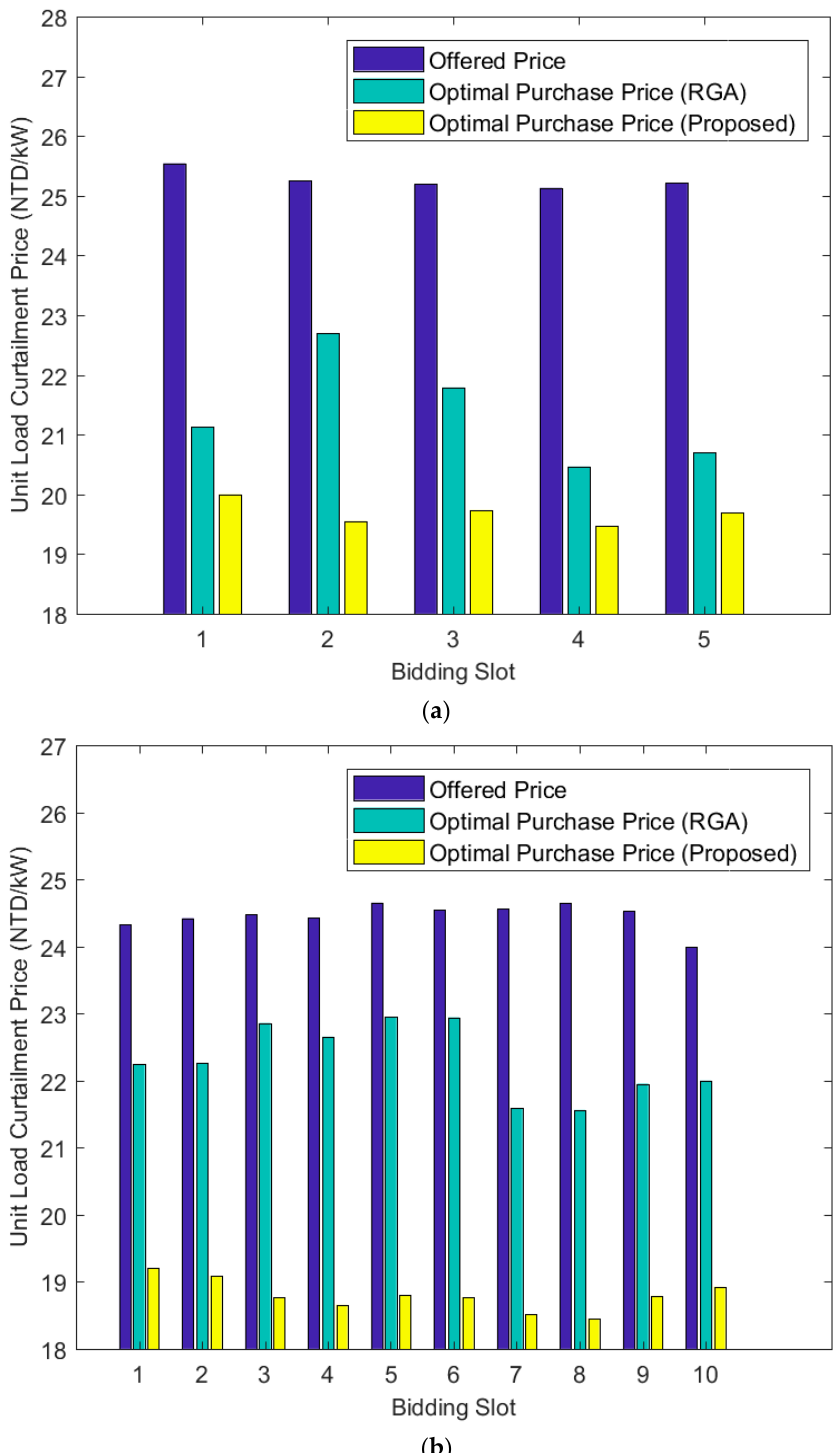
η and optimal m